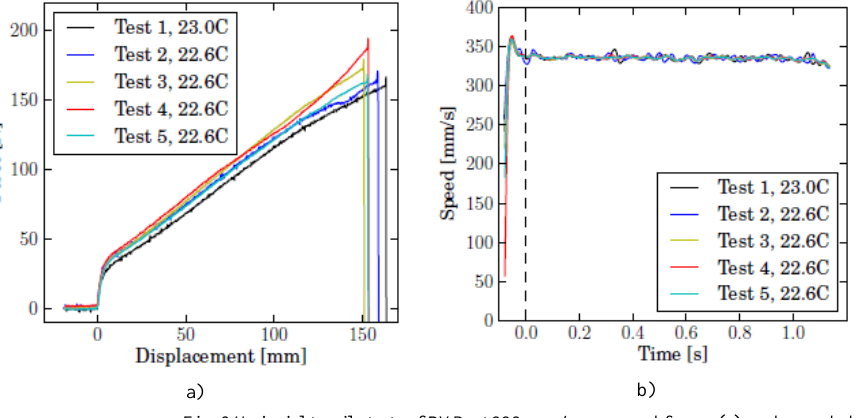
Fig. 6 Uniaxial tensile tests of PVB at 333 mm/s: measured forces (a), and recorded speed